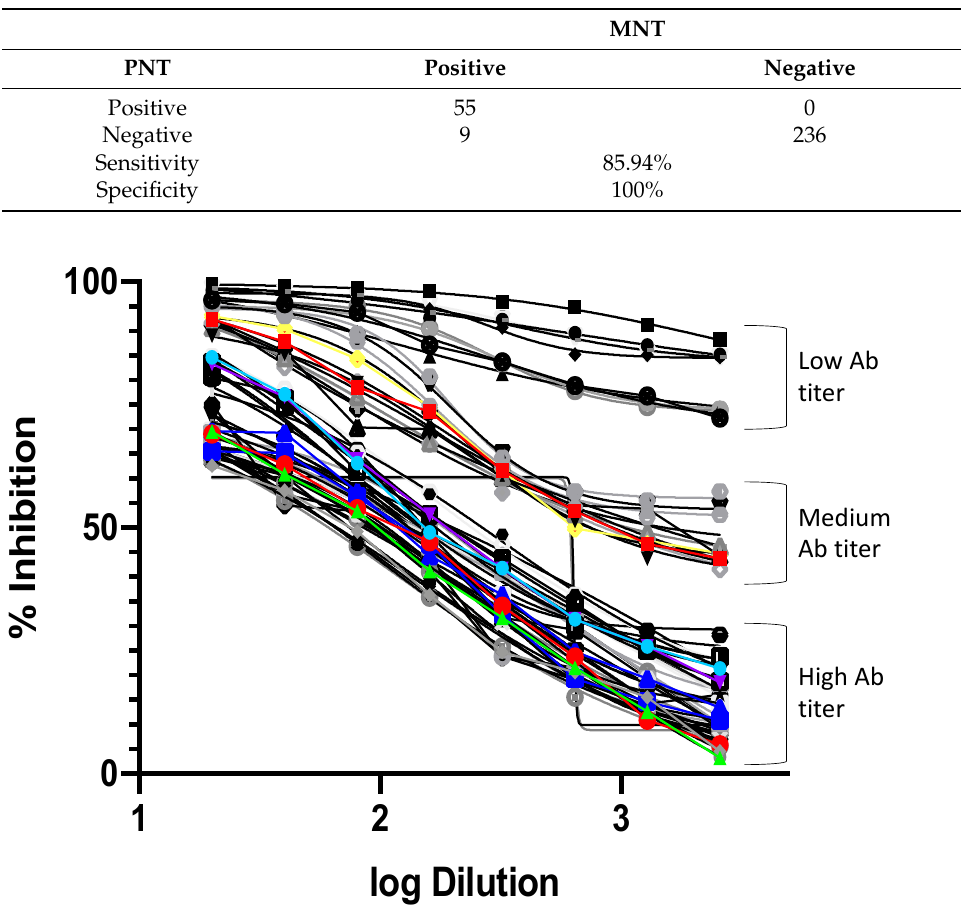
Figure 2. Dilution curves for the positive samples included in the study. The curves are plots of the log sample dilution vs. the percent normalized inhibition for each dilution compared to the positive control. The curves show samples with high, medium, and low titers.